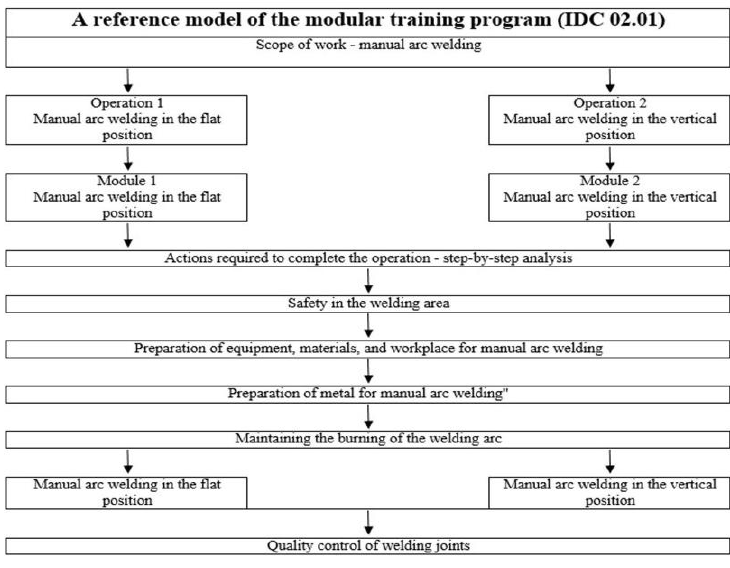
Fig. 2. A reference model of modular technology (IDC